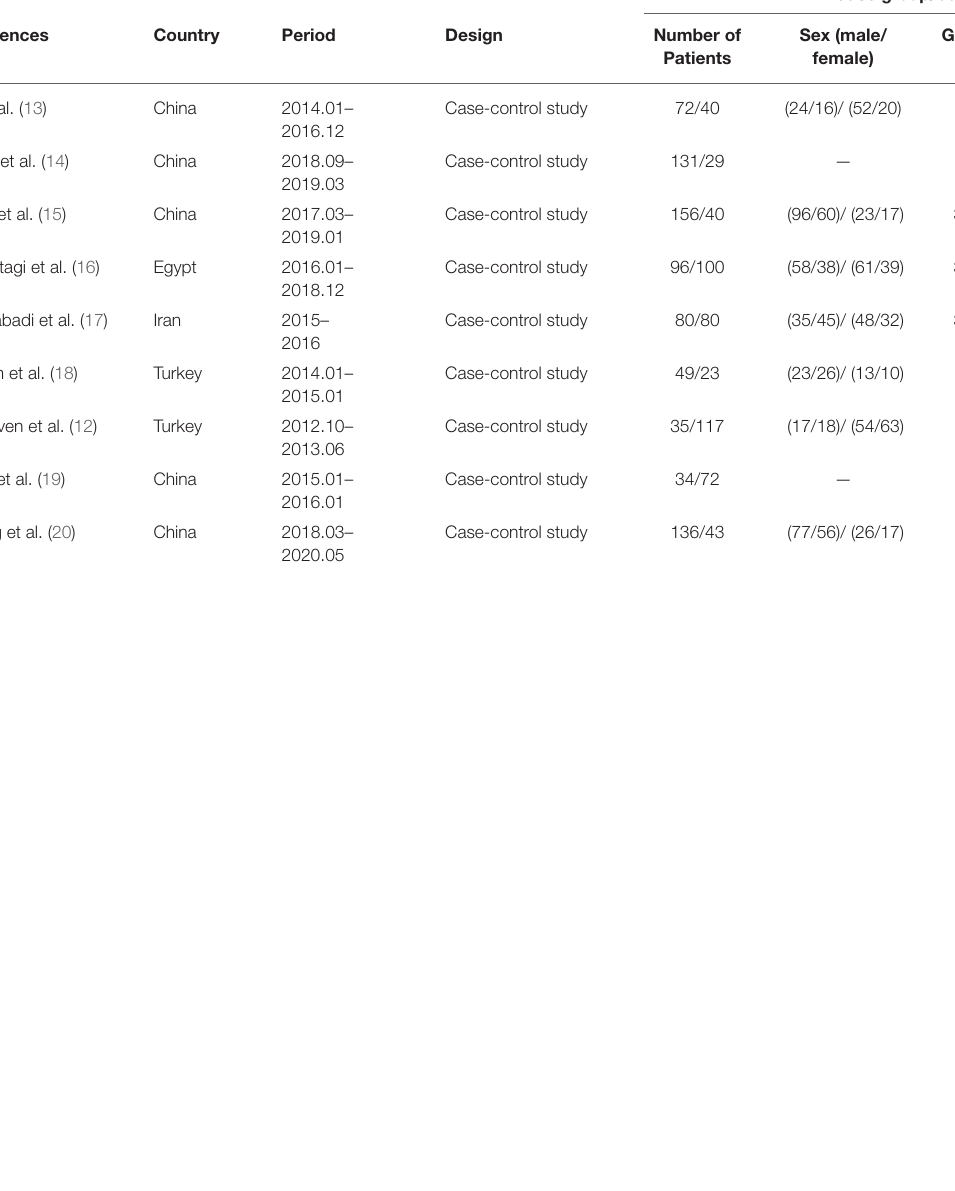
TABLE 2 | Characteristics of studies included in this